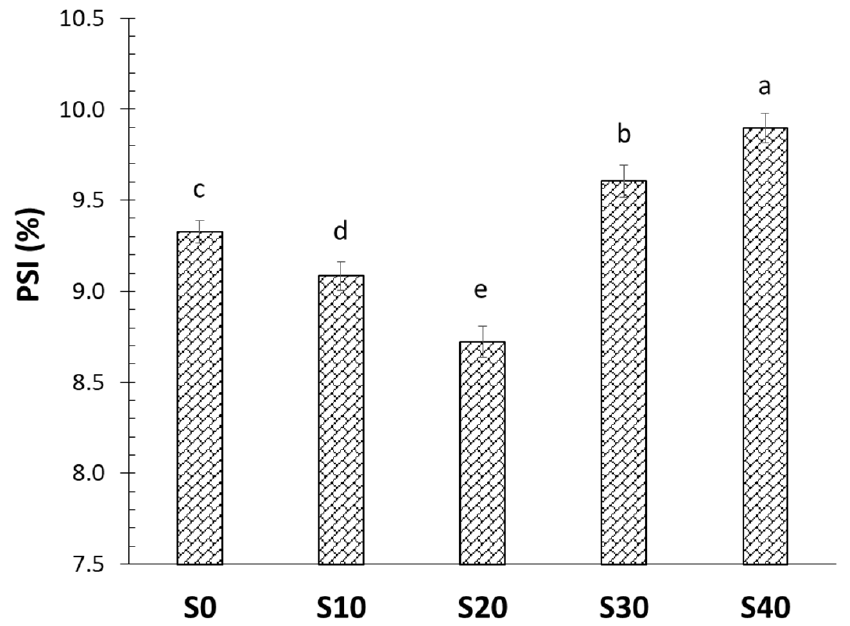
Figure 3. Effect of mycelium addition on protein solubility index at pH 7. All the values are mean ± SD ( n = 3). Different letters on the top of bar show significant difference ( p < 0.05).